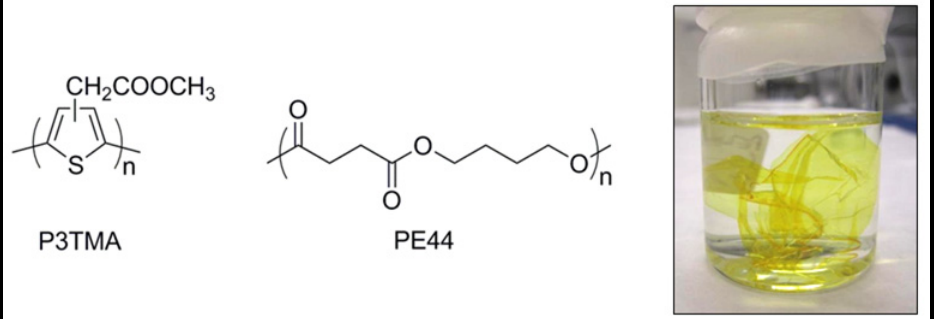
Figure 30. Chemical structures of poly(3-thiophene methyl acetate) (P3TMA) ( left ), and poly(tetramethylene succinate) (PE44) ( middle ) and digital camera image of a P3TMA:PE44 ( right ) free-standing nanomembrane dispersed in